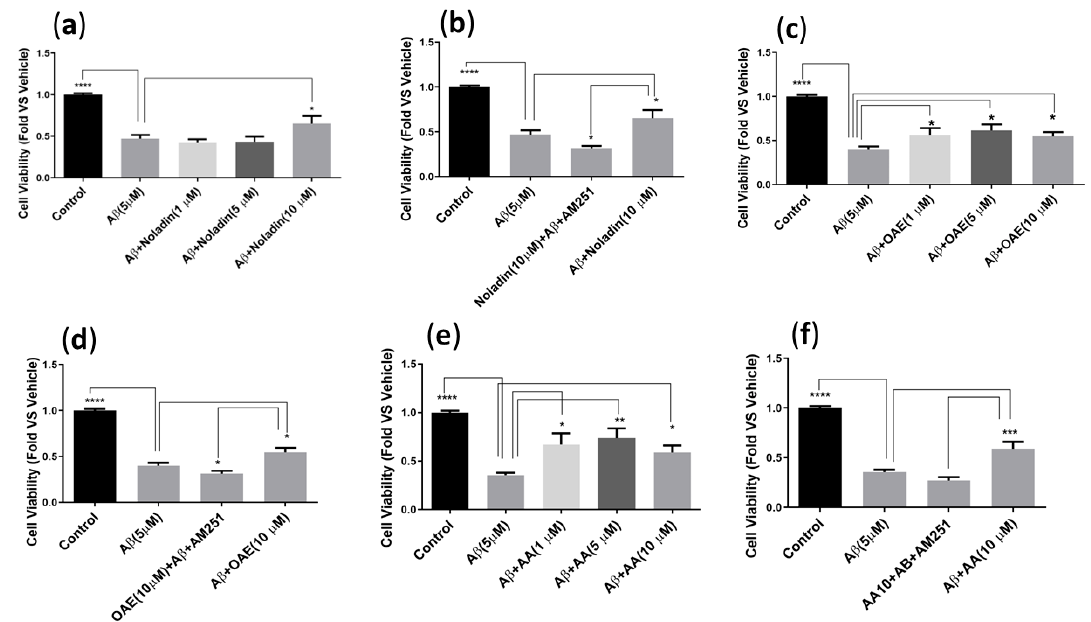
Figure 3. Effect of at 1, 5, 10 μ M endocannabinoids and AA, against A β 42 (5 μ M) toxicity on CHO ‐ CB1 cells. Cells were treated with A β 42 in the absence or presence of Noladin ( a ), OEA ( c ), and AA ( e ), compared to the untreated Control group. The CB1 receptor antagonist, AM251 (5 μ M), was used in panels ( b ), ( d ), and ( f ). Cell viability was determined via MTT assay. A one ‐ way ANOVA with Dunnett’s multiple comparisons performed to establish significance between groups ( α = 0.05